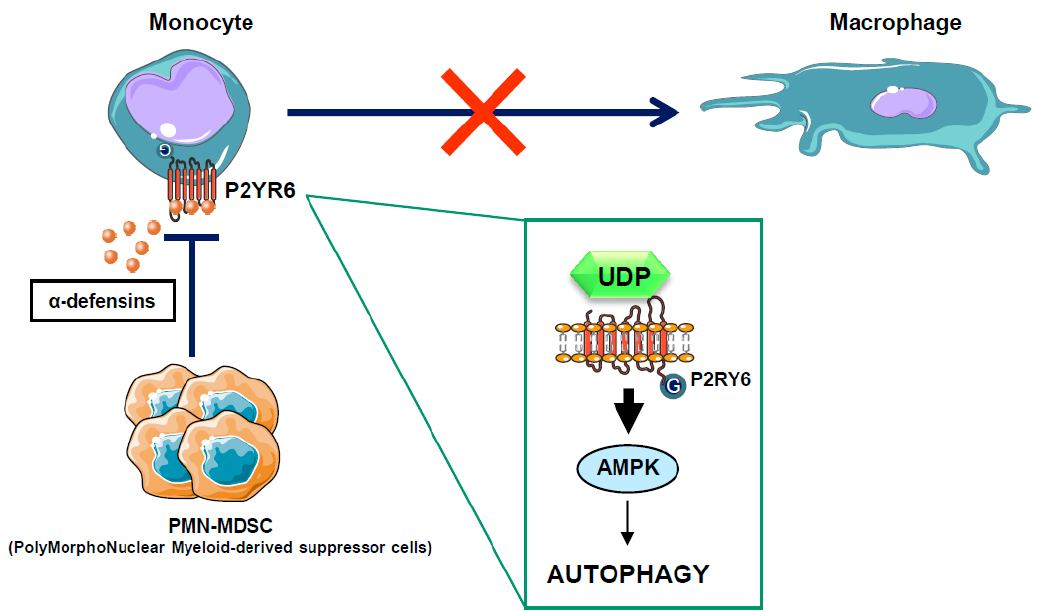
Figure 4. Mode of action for PMN-MDSC in the CMML context. In some CMML patients, PMN-MDSC secretes high levels of alpha-defensins, which antagonize the P2Y6 receptor, block autophagy activation, and inhibit the macrophagic differentiation of monocytes isolated from CMML patients. Alpha-defensin acts as a competitive inhibitor of UDP, the natural ligand of the P2Y6 receptor.